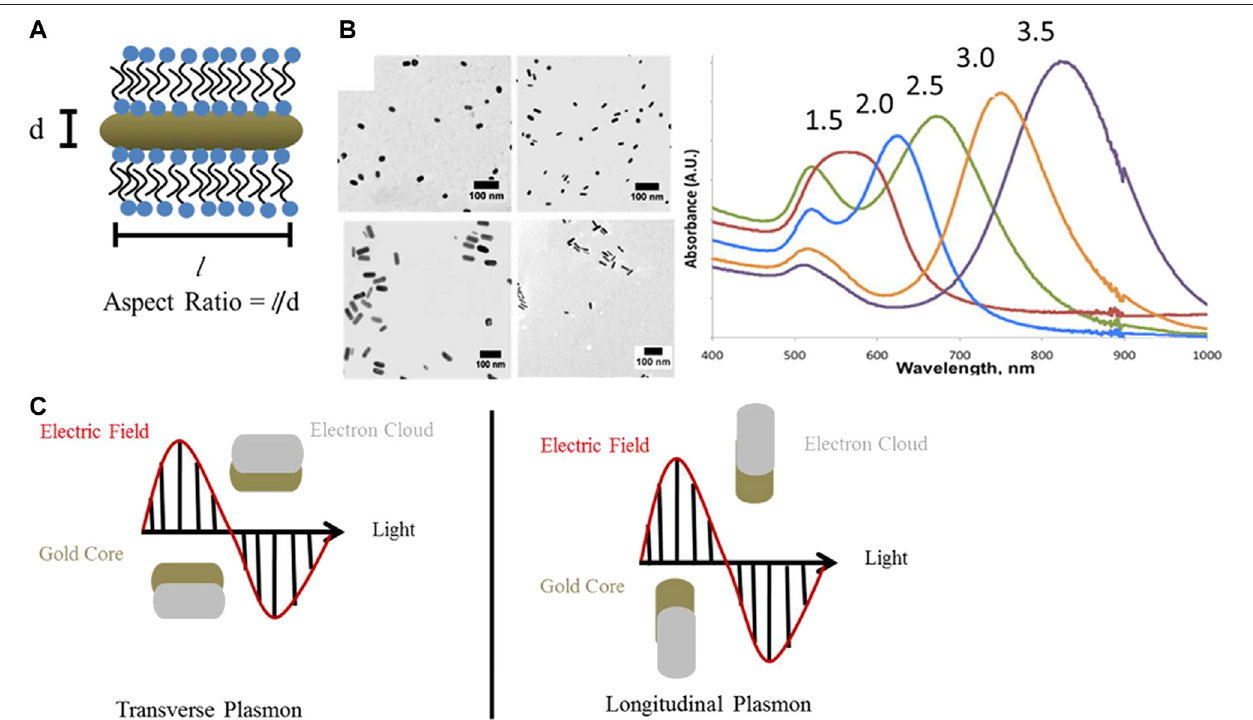
FIGURE1| Opticalpropertiesofgoldnanorods. (A) GNRshavetwosurfaceplasmonresonancebands:onetransverseandtheotherlongitudinal.Thelongitudinal onevarieswiththeaspectratios(AR).AspectRatio (cid:1) l/d. (B) TEMimagesandUV − vis − NIRextinctionspectraofGNRswithAR1.5 – 3.5,aspectratiosareindicatedabove the absorbance spectrum of each sample. Scale bars are 100 nm. (C) Schematic representation of transverse and longitudinal plasmon absorbances in GNRs (Lohse and Murphy 2013).